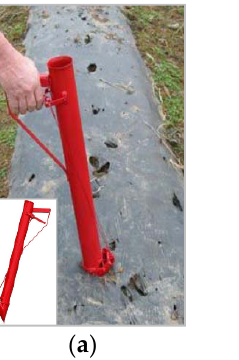
Figure 12. Hand-held potato planters. ( a ) Jab planter. Reprinted with permission from ref. [43]. Copyright 2020 Stand ‘n Plant; ( b ) double-handle bulb planter. Reprinted with permission from ref. [44]. Copyright 2020 Groves Nurseries & Garden Centre; ( c ) manual-drawn potato planter. Reprinted with permission from ref. [45]. Copyright 2008 Central Potato Research Institute.